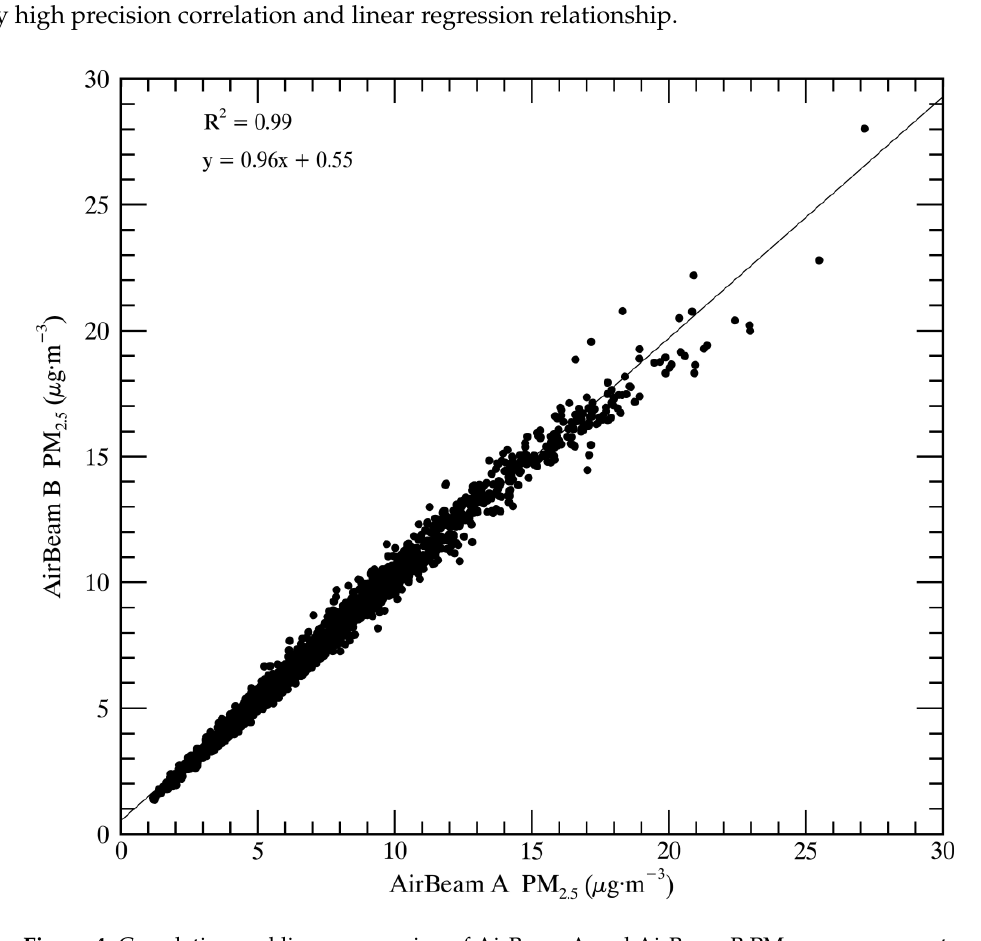
Figure 4. Correlation and linear regression of AirBeam A and AirBeam B PM 2.5 measurements.